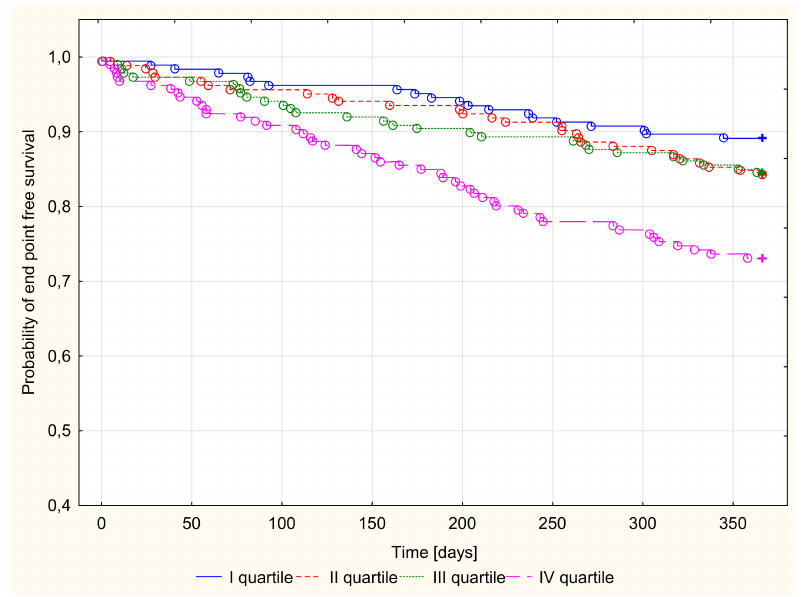
Figure 1. Probability of survival of time free of death or heart transplantation depending on quartiles of ceruloplasmin concentration in 1-year follow-up, p < 0.001.